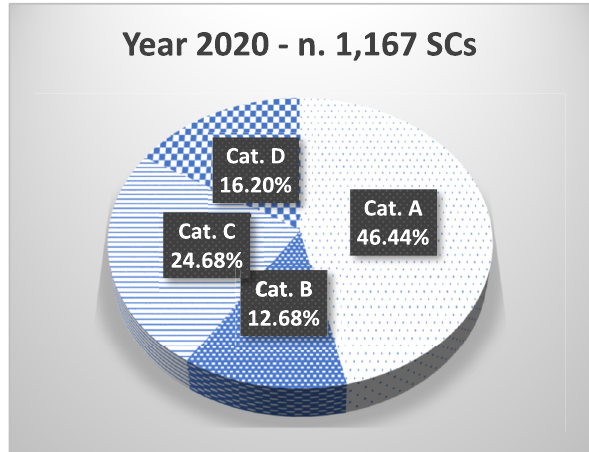
Figure 4: Percentage frequency by categories, year